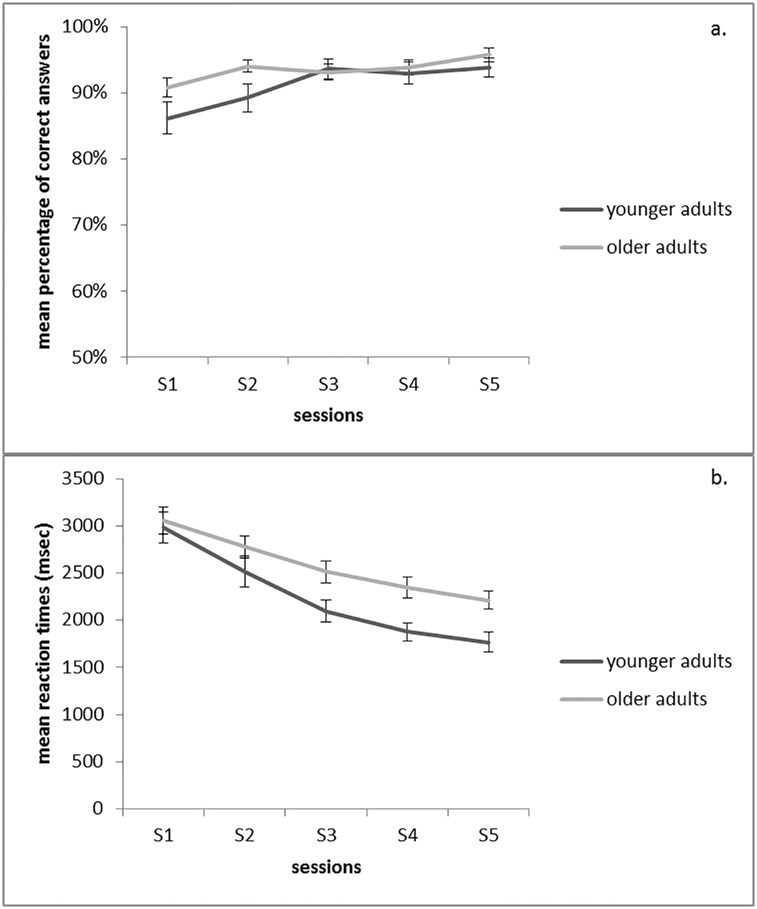
Mean percentage of correct answers (panel a) and mean reaction times in correct trials (panel b) as a function of training session (S1, S2, S3, S4, S5) and group (younger adults, older adults).Bars indicate the standard error of the mean.